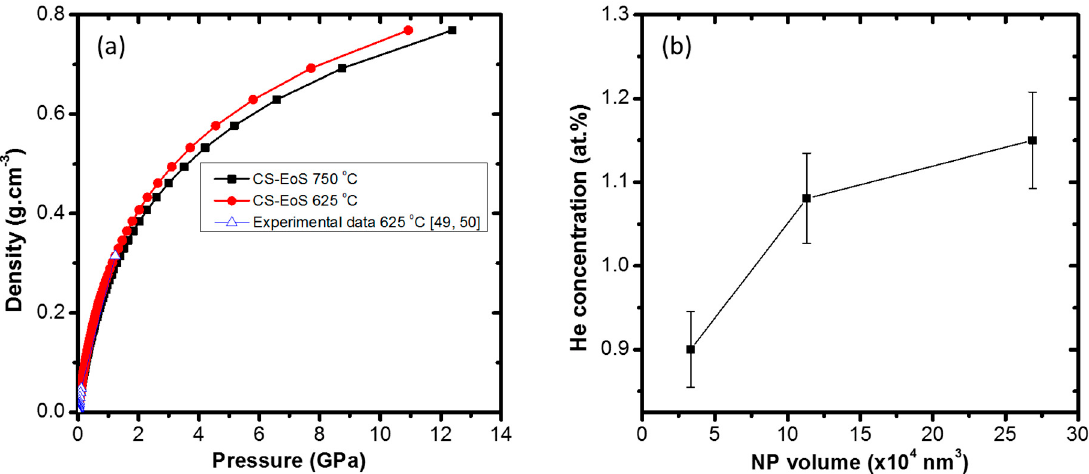
Figure 6. Plots of: ( a ) calculations and experimental data [49,50] for density as a function of pressure for He at 625 ◦ C and 750 ◦ C; and ( b ) relationship between He concentration (based on resolvable bubbles) and NP volume at a fluence of 1.1 × 10 17 ions · cm − 2